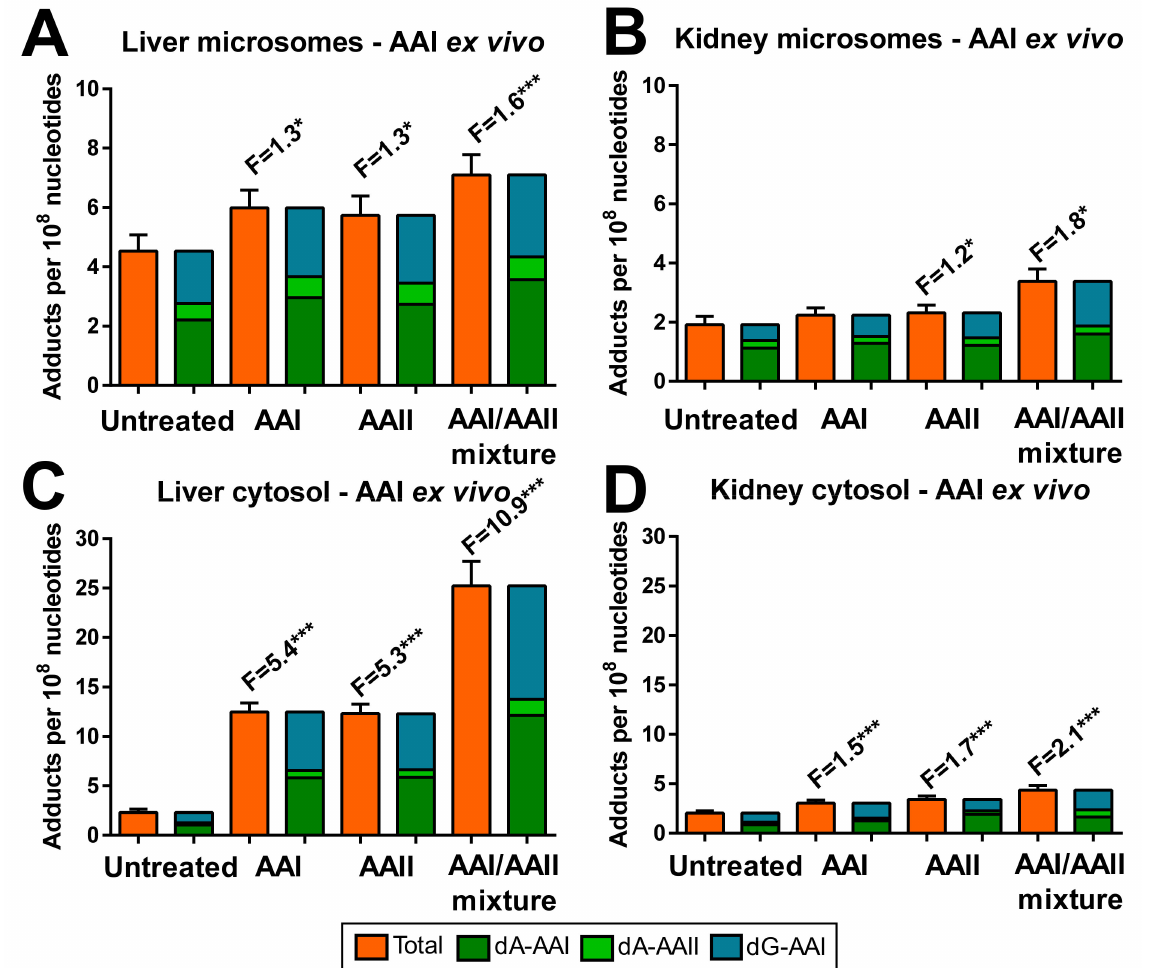
Figure 5. DNA adduct formation ex vivo by AAI in rat microsomal fractions of livers ( A ) and kidneys ( B ) from control (untreated) rats and rats pre-treated with AAI, AAII or AAI/AAII mixture, as determined by 32 P-postlabelling. DNA adduct formation ex vivo by AAI in rat cytosolic fractions of livers ( C ) and kidneys ( D ) from control (untreated) and rats pre-treated with AAI, AAII or AAI/AAII mixture, as determined by 32 P-postlabelling. All values are given as the means ± SD ( n = 3). Numbers above columns (‘F’) indicate fold changes in DNA adduct levels compared to control (untreated). Comparison was performed by t -test analysis: * p < 0.05, *** p < 0.001, differences from control (untreated). Note different scaling when comparing AA-DNA adduct levels in microsomal and cytosolic fractions. Negative control incubations were performed either ( i ) without cytosol or microsomes, ( ii ) without NADPH, ( iii ) without DNA or ( iv ) without AAI and were devoid of DNA